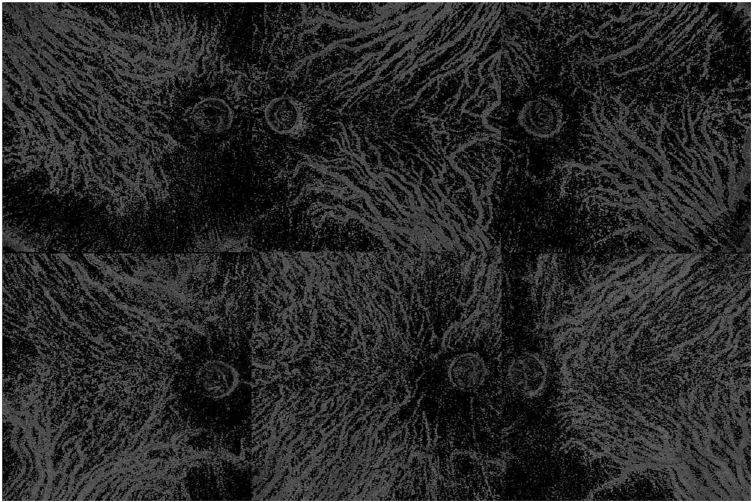
Figure 4. Additional representative choroidal blood flow pattern of the middle and large choroidal vessels. ( A ) Case 13. Right eye. Subfoveal choroidal thickness is 290 µ m. Ratio of flow area is 23.0%. ( B ) Case 14. Left eye. 260 µ m. 25.8%. ( C ) Case 22. Left eye. 280 µ m. 19.3%. ( D ) Case 30. Right eye. 260 µ m. 28.3%. ( E ) Case 35. Right eye. 260